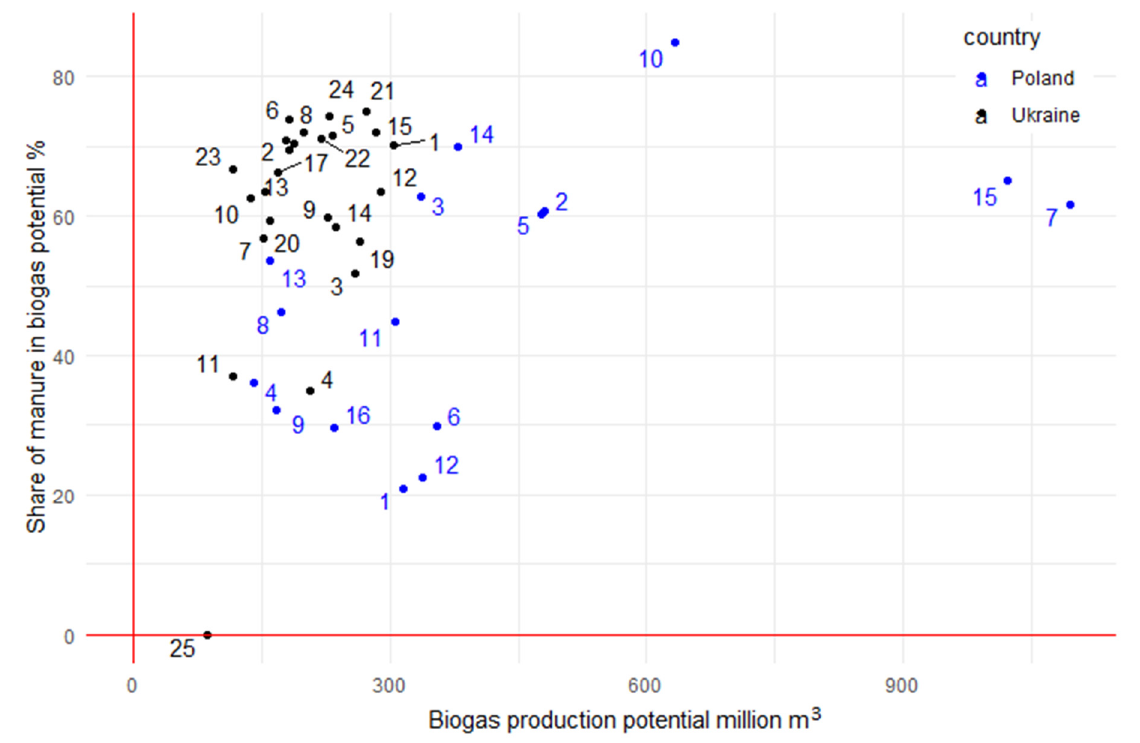
Figure 3. Basic biogas production potential in terms of the percentage of natural fertilizers. Source: Own study.